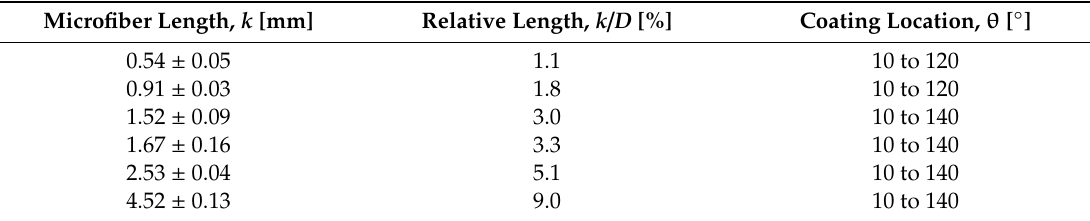
Table 1. Microfiber coating parameters.